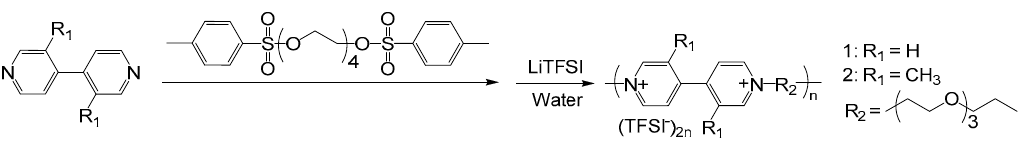
Figure 7. Synthesis of polyviologens via Menshutkin reaction.